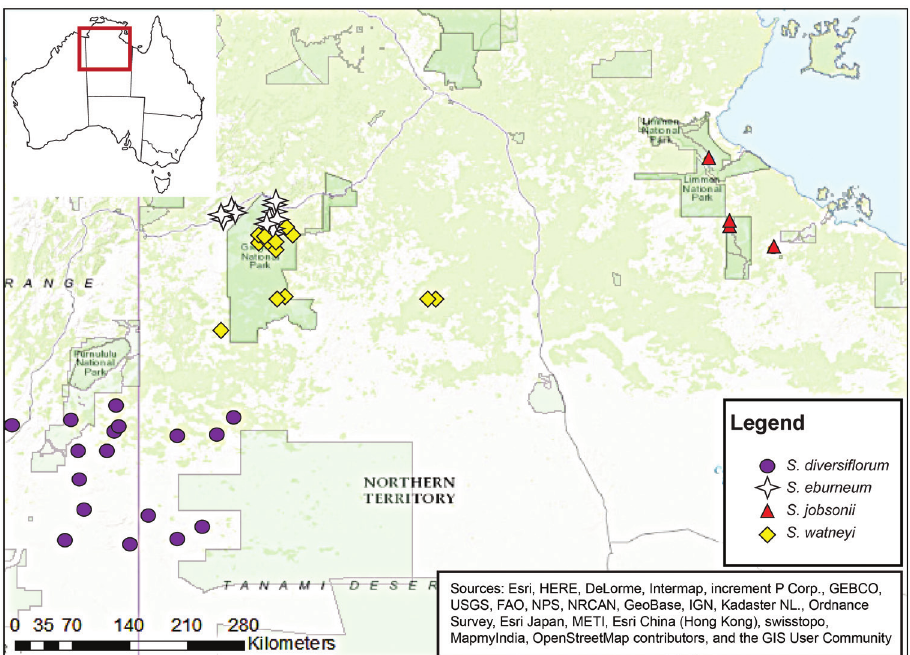
Figure 3. Geographic distribution of S. watneyi , S. eburneum , S. diversiflorum , and S. jobsonii in eastern Western Australia and the Northern Territory, Australia, based on specimens held at the Northern Terri- tory Herbarium Palmerston